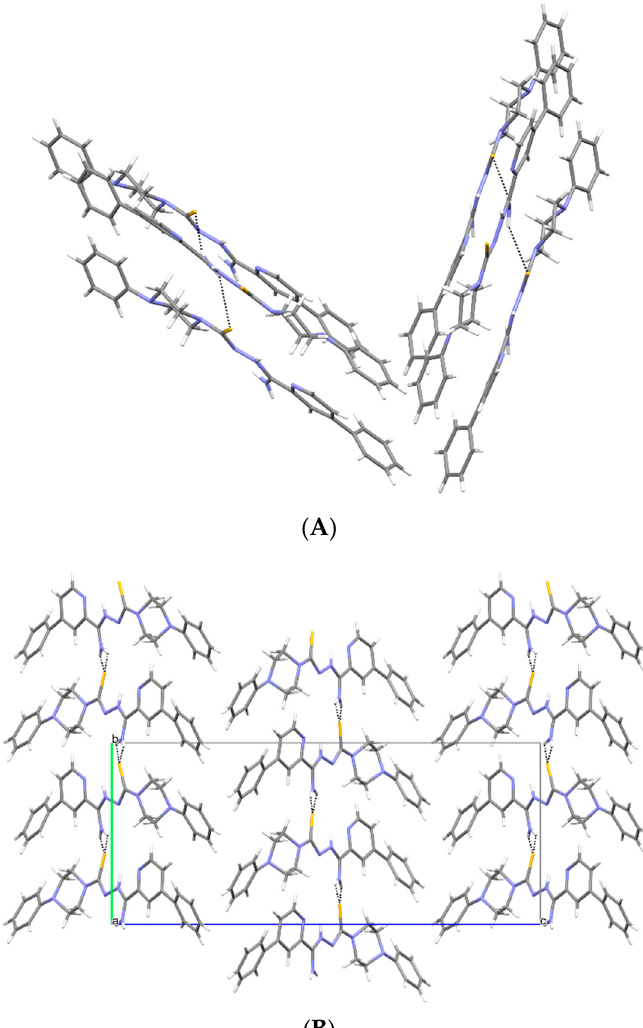
Figure 10. ( A ) Intermolecular hydrogen bonds in 1c . ( B ) The packing of molecules in 1c (a, b, c— unit cell). The superposition of the molecules (Figure 11) indicates that the zwitterion form stabilizes the stretched form, and all compounds assume a similar conformation.